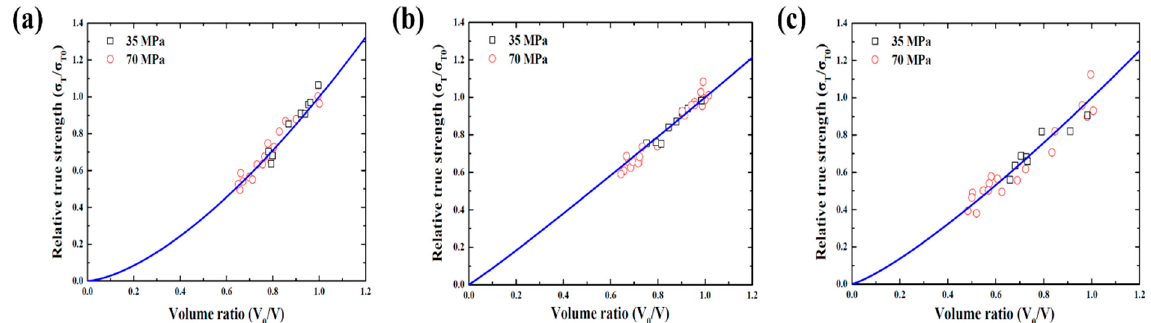
Figure 12. Relationship between relative true strength and volume ratio. ( a ) NBR, ( b ) EPDM, ( c ) FKM.